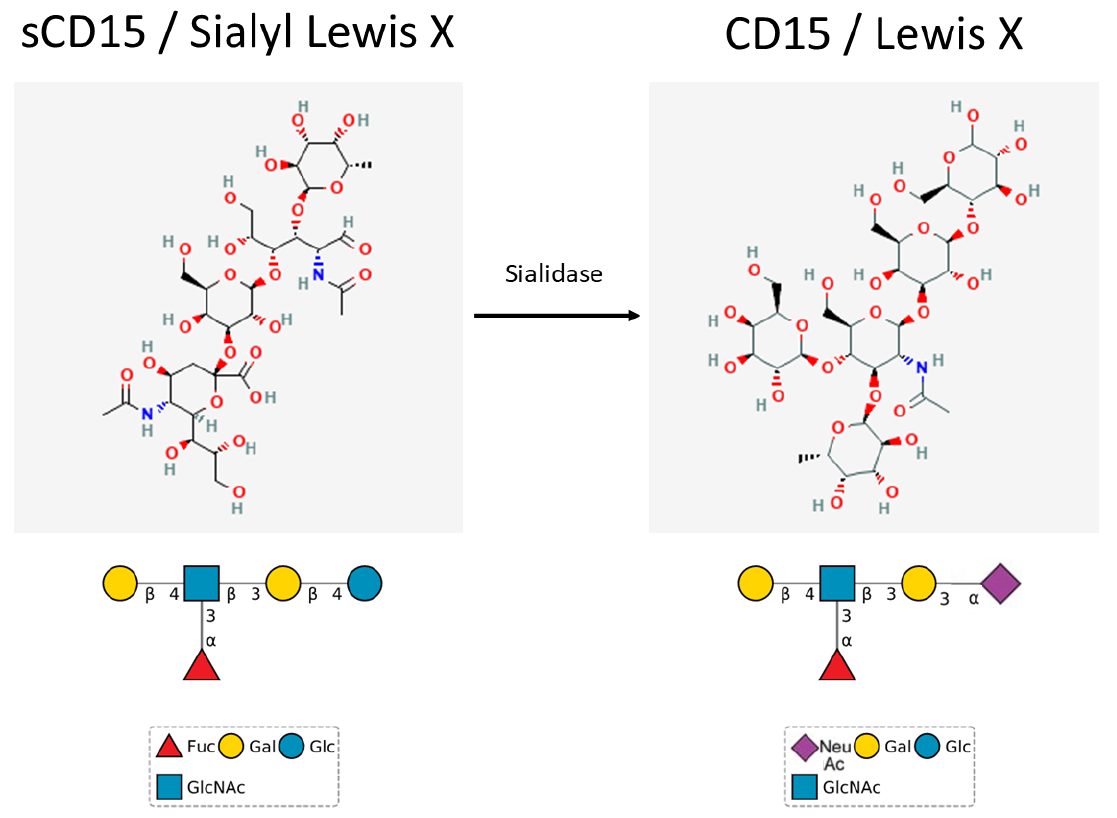
Figure 1. Structures of CD15 and CD15s, with the enzymatic reaction canalized by sialidase.